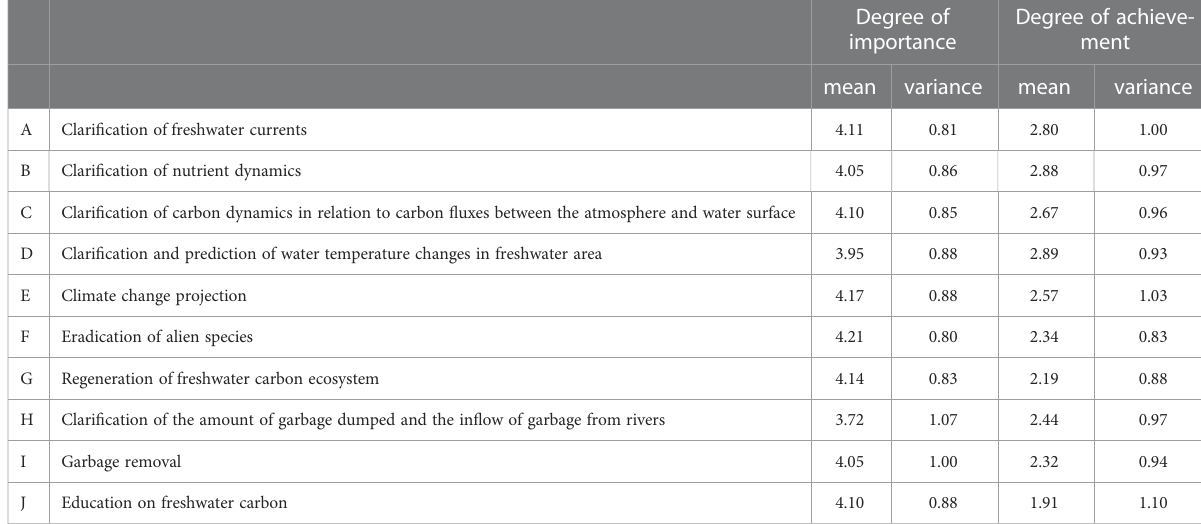
TABLE 3 The average value and variance of the answers to the ten questions regarding freshwater